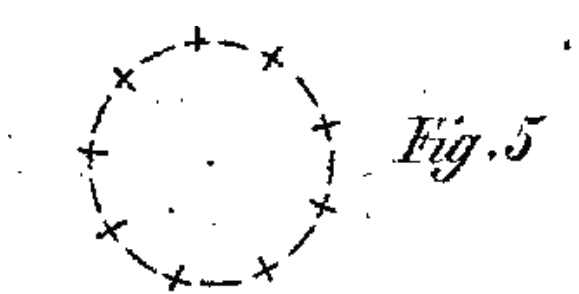
Figure 4. Circular current in a liquid which consists of positively and negatively charged particles. Grotthuß did not call them ions in his text, because this term was unknown in his time. Note that no electric potential is applied, and therefore no current flows through the liquid. Taken from ref. [53]